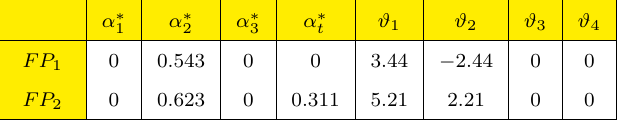
Table 1 . Fixed points and their scaling exponents for the SM in the 210 approximation